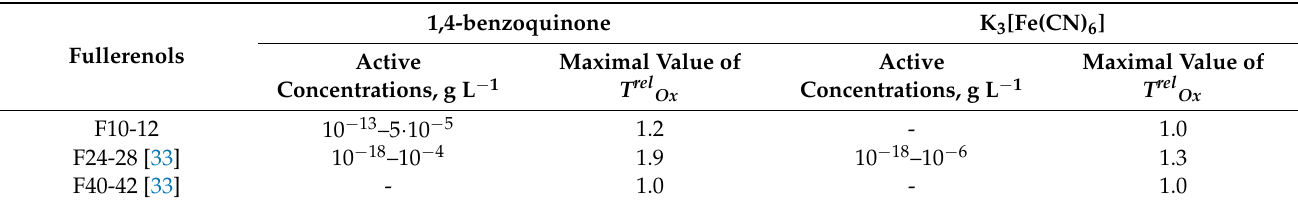
Table 3. Range of active concentrations and maximal values of T rel Ox for fullerenols in model oxidizer solutions of 1,4-benzoquinone and K 3 [Fe(CN) 6